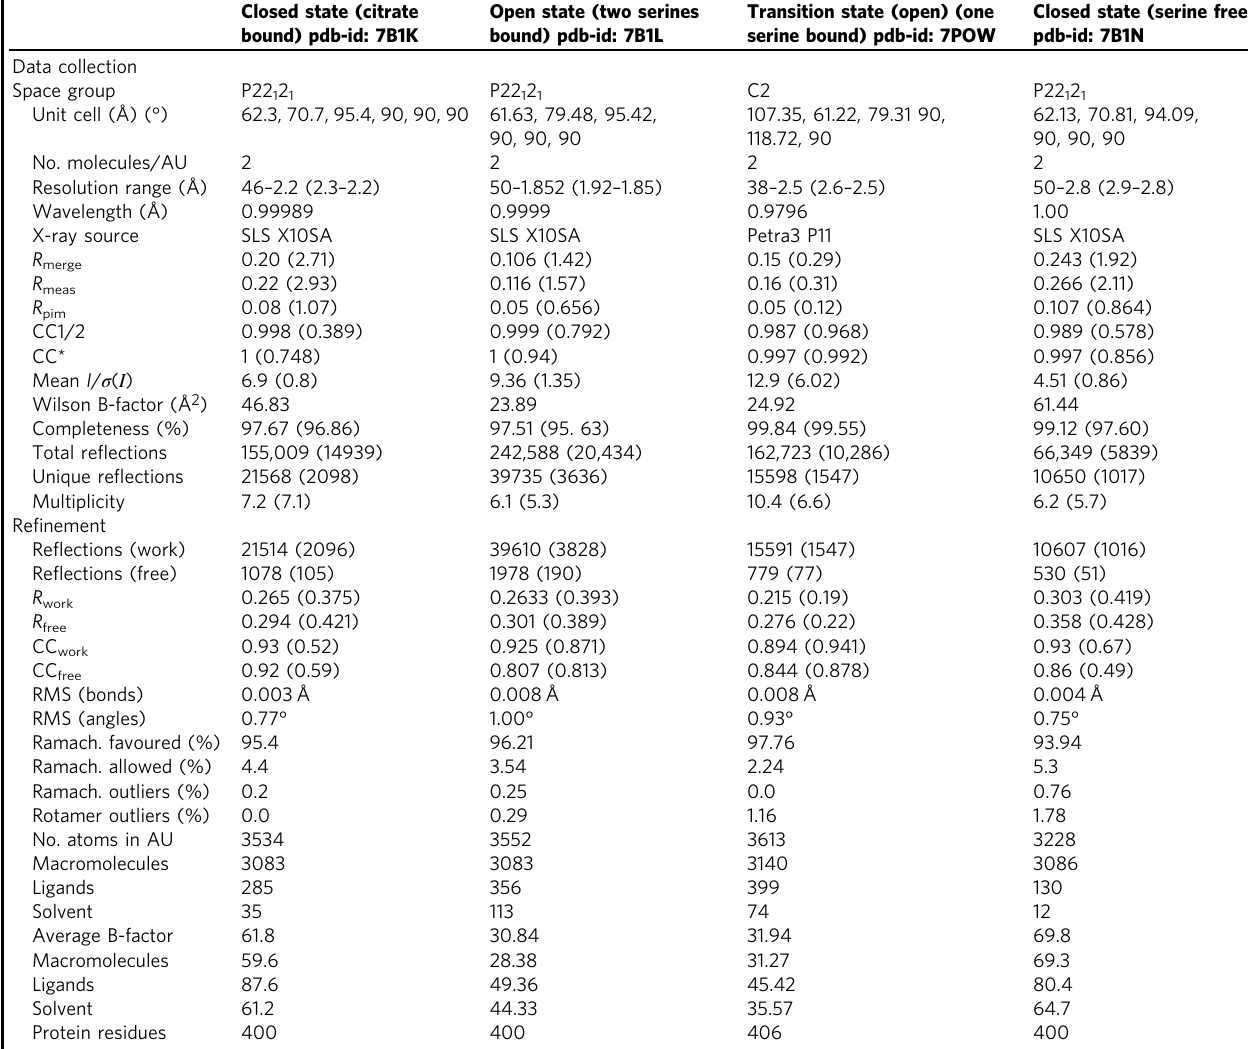
Table 1 Data collection and re fi nement